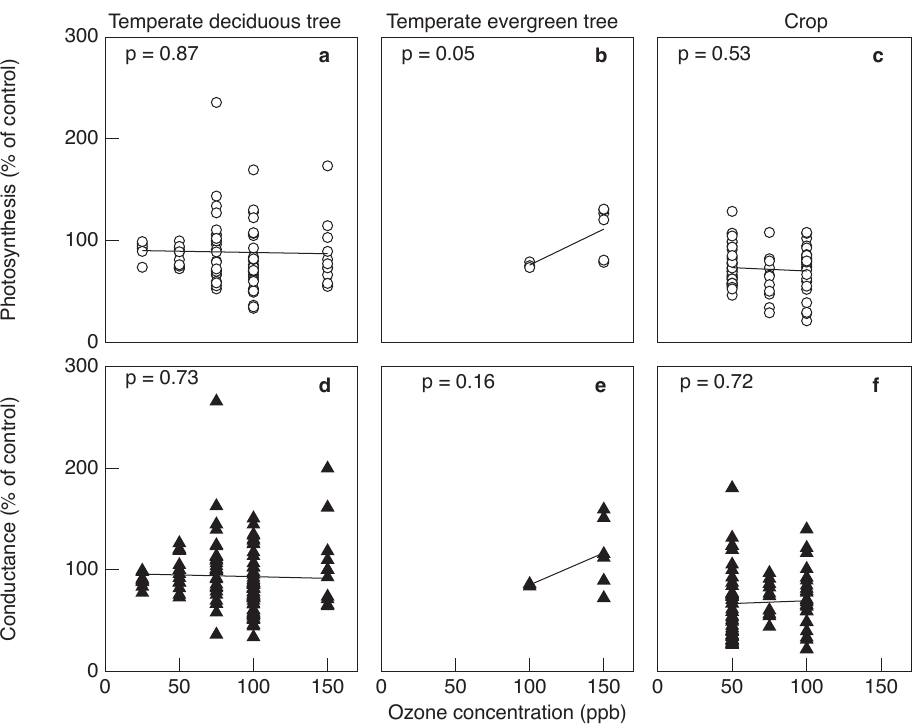
Fig. 7. The correlation of photosynthesis (open symbols; a–c ) and conductance (closed symbols; d–f ) to 25ppb ozone concentration bins for temperate deciduous trees (a, d) , temperate evergreen trees (b, e) and crops (c, f) for all data that is compared to control plants exposed to charcoal-filtered air with medium or high confidence in cumulative O 3 uptake (CUO) calculations. Response values are reported as % of control (treatment/control). r 2 values are only included for significant correlations, and n values are the number of data points included in the